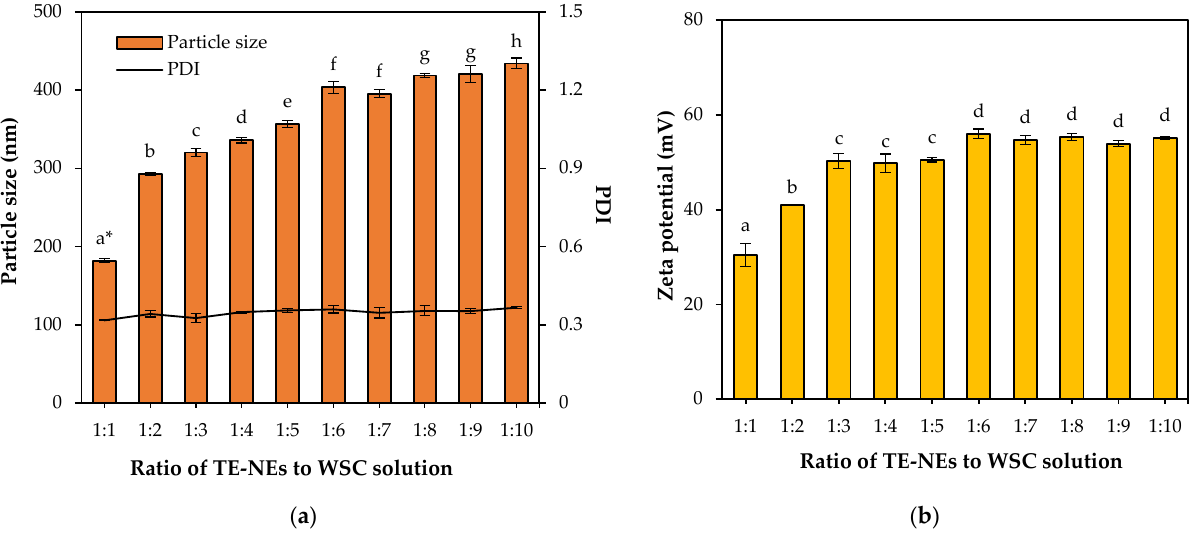
Figure 2. Effect of ratio of nanoemulsion to water-soluble chitosan on the physicochemical properties of the WCS-TE-NEs. ( a ) Particle size and PDI; ( b ) zeta potential of the WCS-TE-NEs. * Different letters indicate significant differences at p < 0.05 by Duncan’s multiple range test.